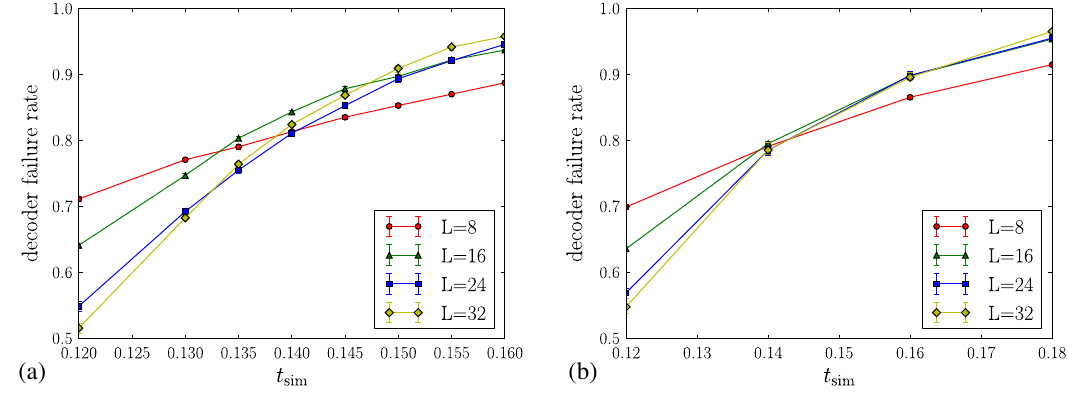
FIG. 7. (a) Logical j 0 i state failure probability versus simulation time (average errors per edge) for γ ψ c ¼ γ σ c using the simple clustering decoder. (b) Logical j 0 i state failure probability versus simulation time for γ ψ c ¼ γ σ c using the fusion-aware clustering decoder. These plots both use the Ising fusion code. We see that the performance of the clustering-type decoders is poorer than the PMA-type decoder for the same noise models, though they still exhibit a